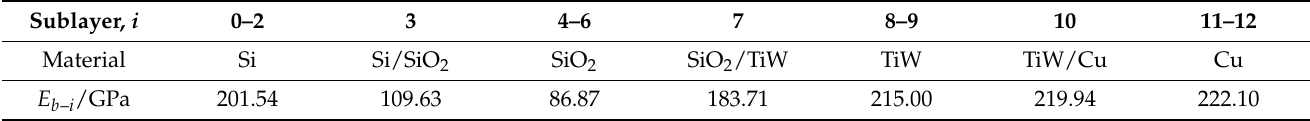
Table 3. Samples after thermal cycling.